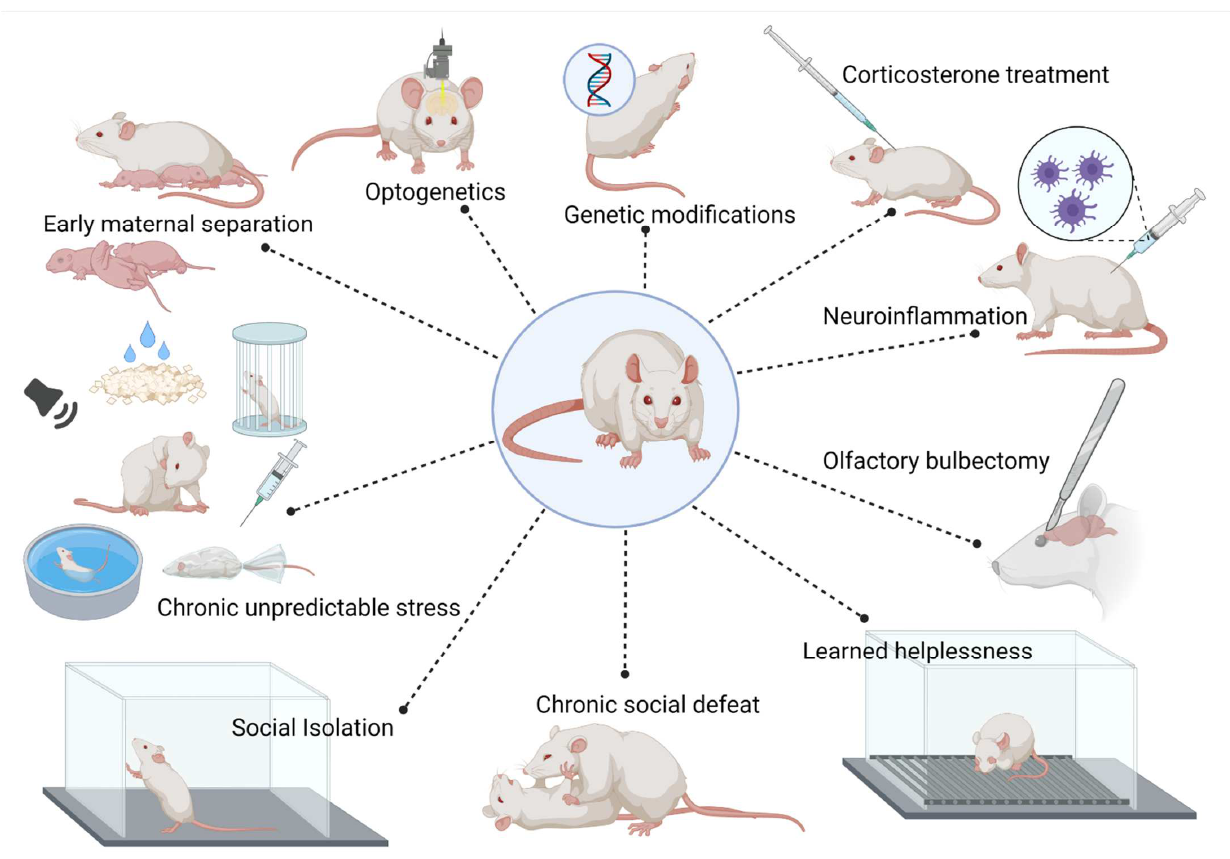
Figure 1. Animal models of anxiety and depression disorders. Most animal models are based on stress exposition at different temporal windows. However, other models have emerged by surgical, genetic, immune, and hormonal manipulations. For reference, see the main text. Created with Bi- oRender.com (accessed on 15 February